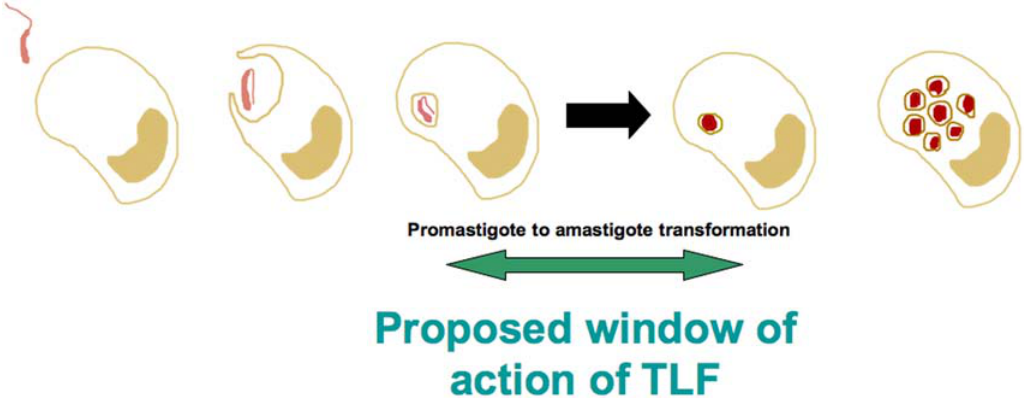
Figure 11. Proposed model of action of TLF against Leishmania parasites. The window of Leishmania susceptibility to lytic HDL is after phagocytosis of the metacyclic promastigotes during acidification of the PV and before transformation into